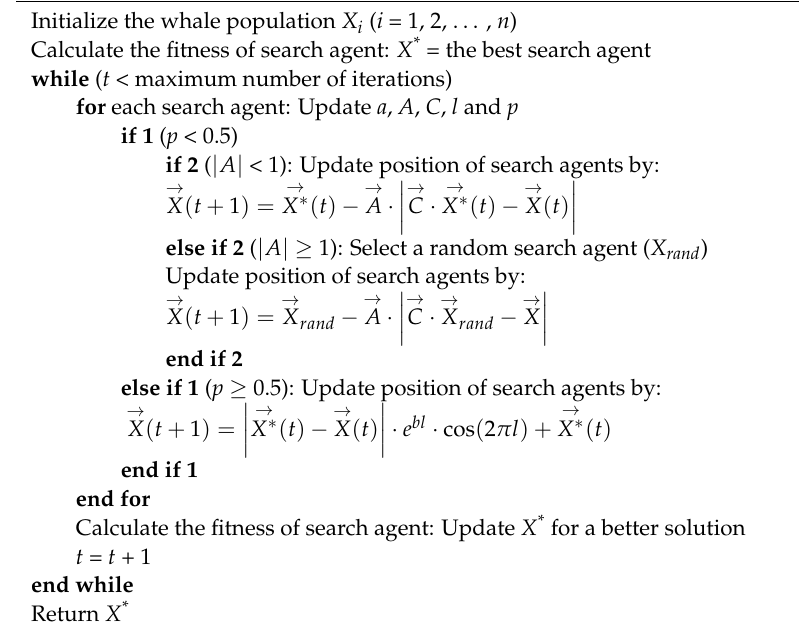
Algorithm A1. Pseudo-code of the whale optimization algorithms